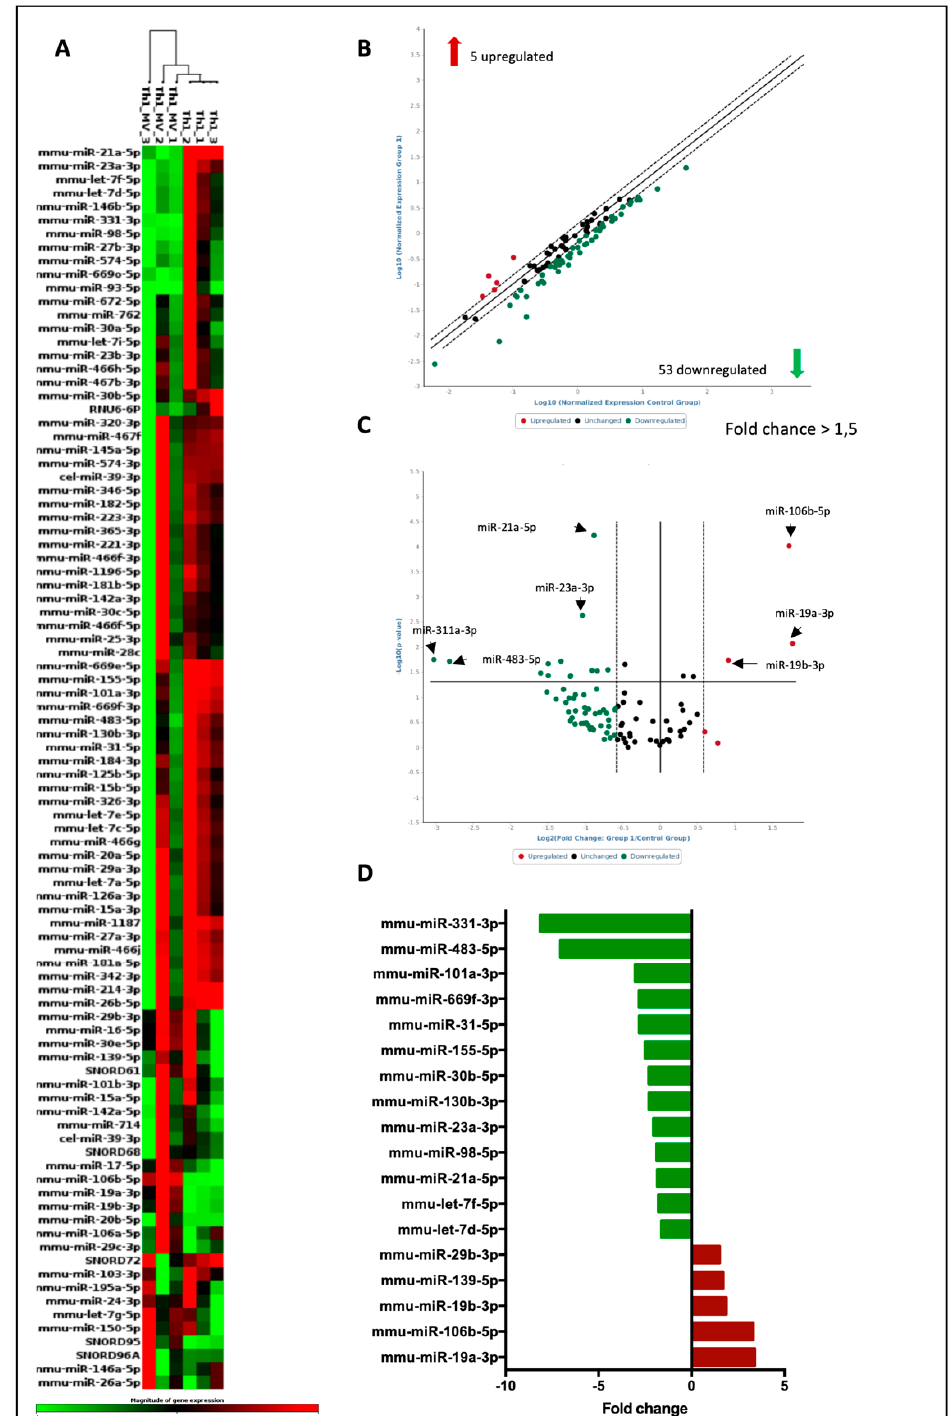
Figure 6. PCR array of miRNAs expressed from Th1 differentiated cells: Comparative heat map of miRNAs in MSC-EVs treated and untreated groups ( A ). Graphs representing differentially expressed miRNAs with fold change > 1.5 ( B ) and differentially expressed miRNAs with significant variation (p <0.05) ( C ). Bar graph demonstrating the miRNAs with the highest variations ( D ). n = 3 (* p <0.05).